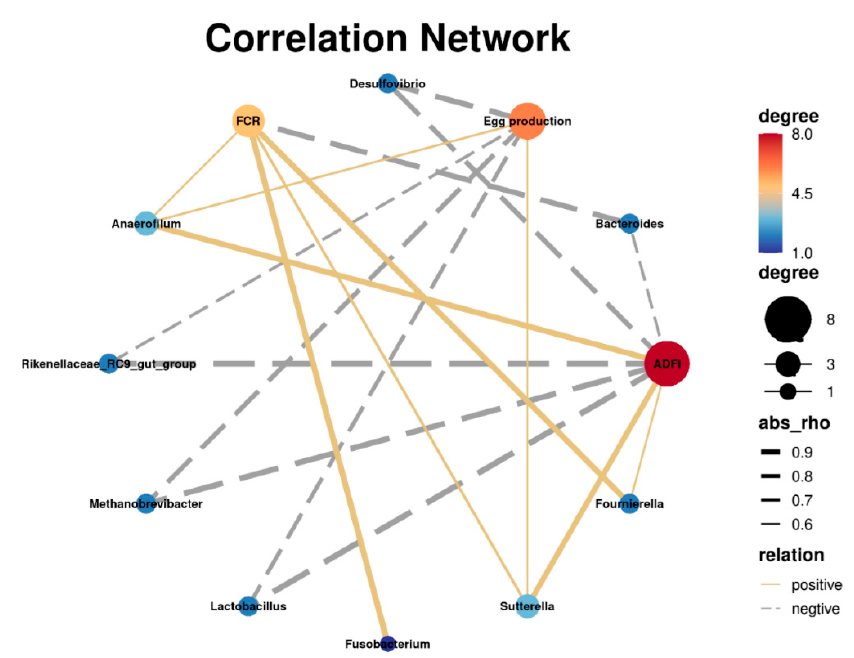
Figure 3. Pearson’s correlation analysis between the abundances of cecal microbiota (at genus level) and egg production. FCR, feed conversion ratio; ADFI, average daily feed intake.